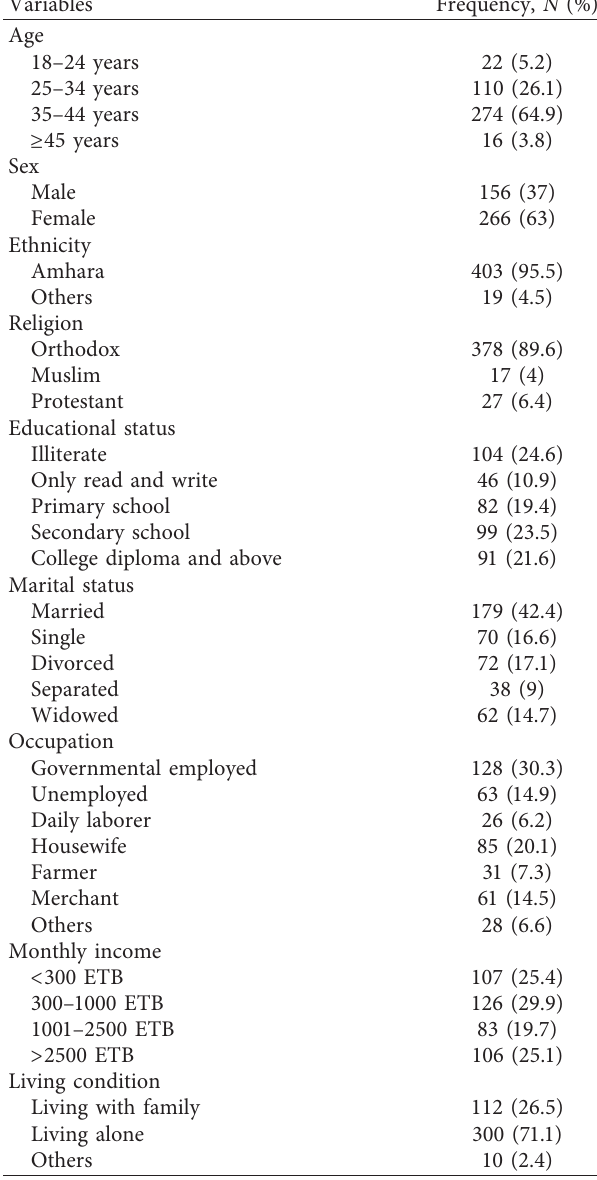
Table 1: Sociodemographic characteristics of study participants at selected hospitals’ ART clinics, North Shewa Zone, Amhara Re- gional State, Ethiopia, 2017 ( n �